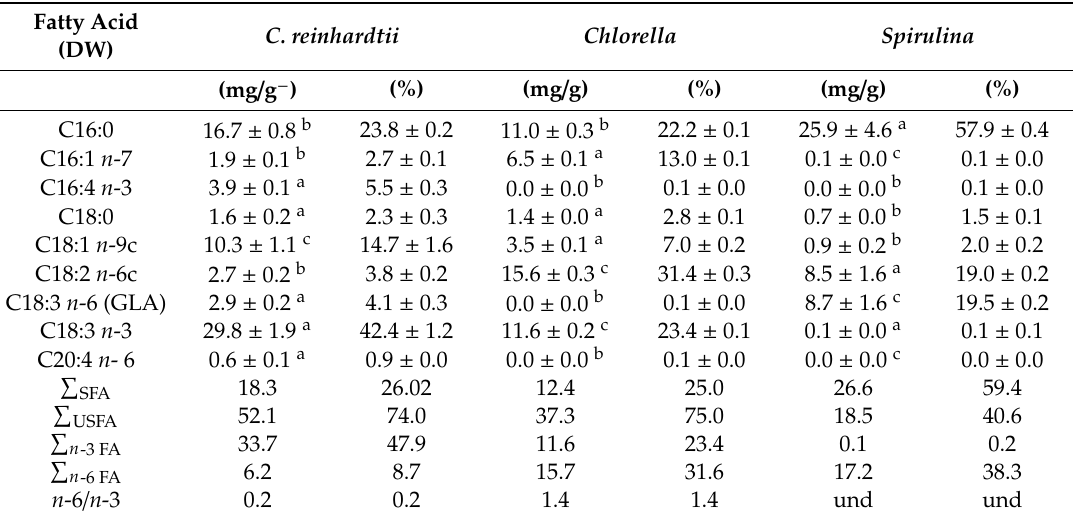
Table 2. Fatty acid profile of C. reinhardtii , Spirulina and